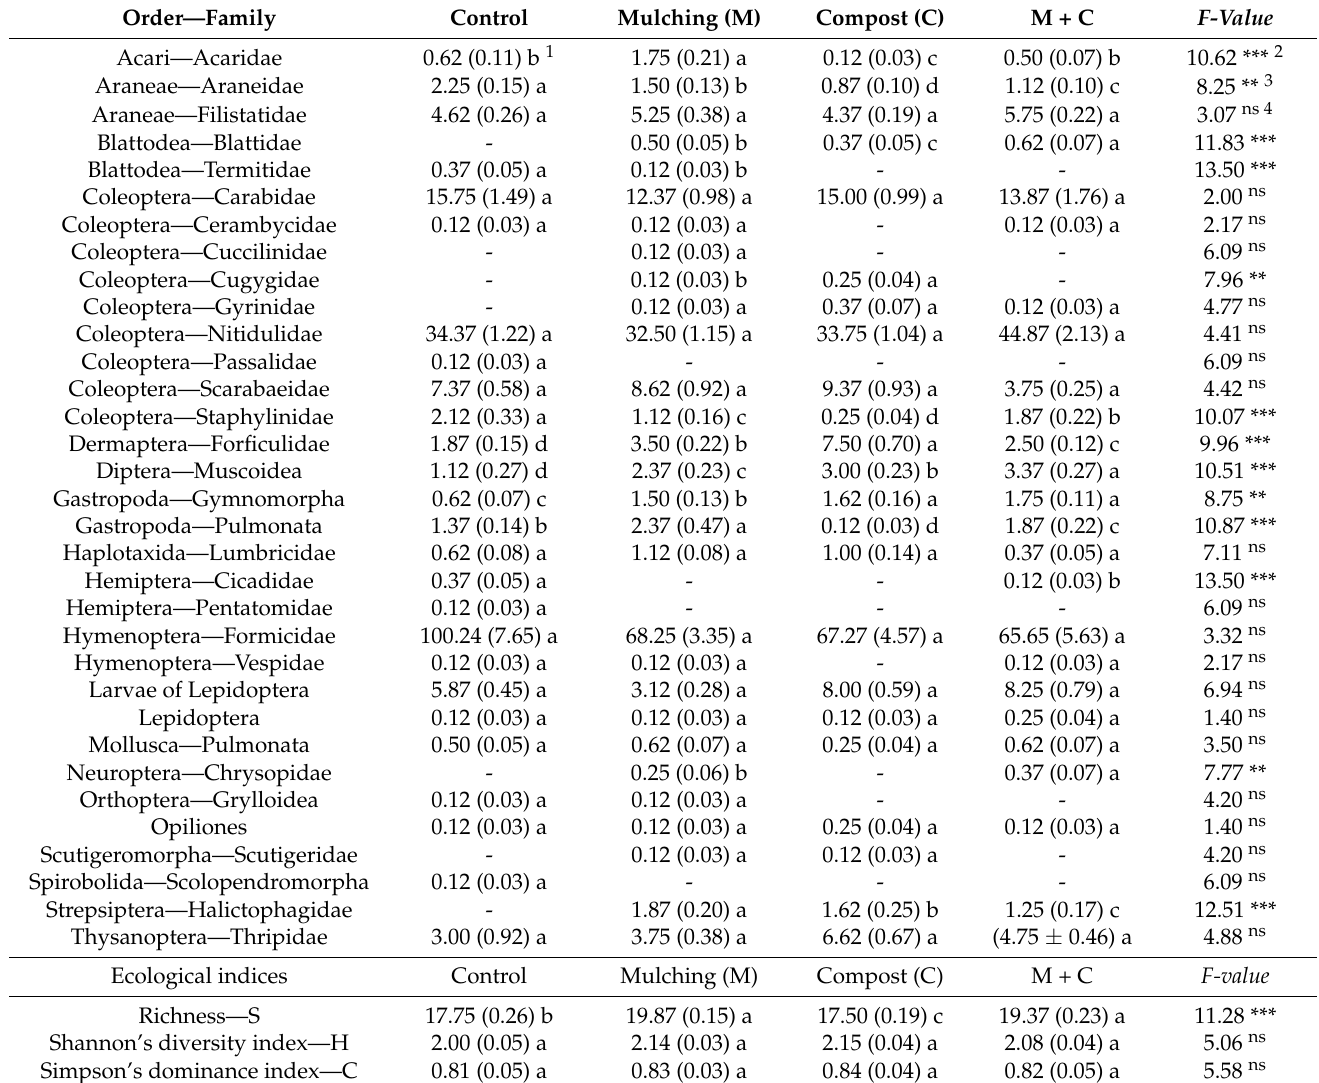
Table 4. Mean abundance (ind. trap − 1 ) of soil organisms’ taxonomic groups, and ecological indexes among the studied organic residue management in a 16-year P. pyrifolia